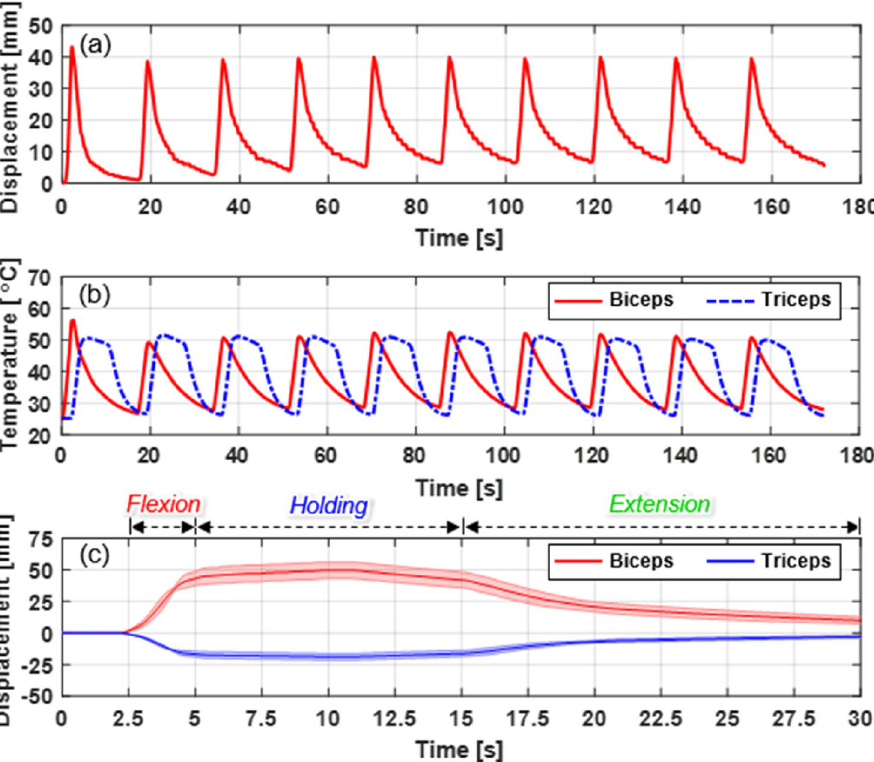
Figure 7. ( a ) BFM displacement when repeating flexion–extension motion 10 times in Condition 3. ( b ) Temperature change of BFM and TFM when repeating flexion–extension motion in Condition 3. ( c ) Displacement of BFM and TFM during temperature